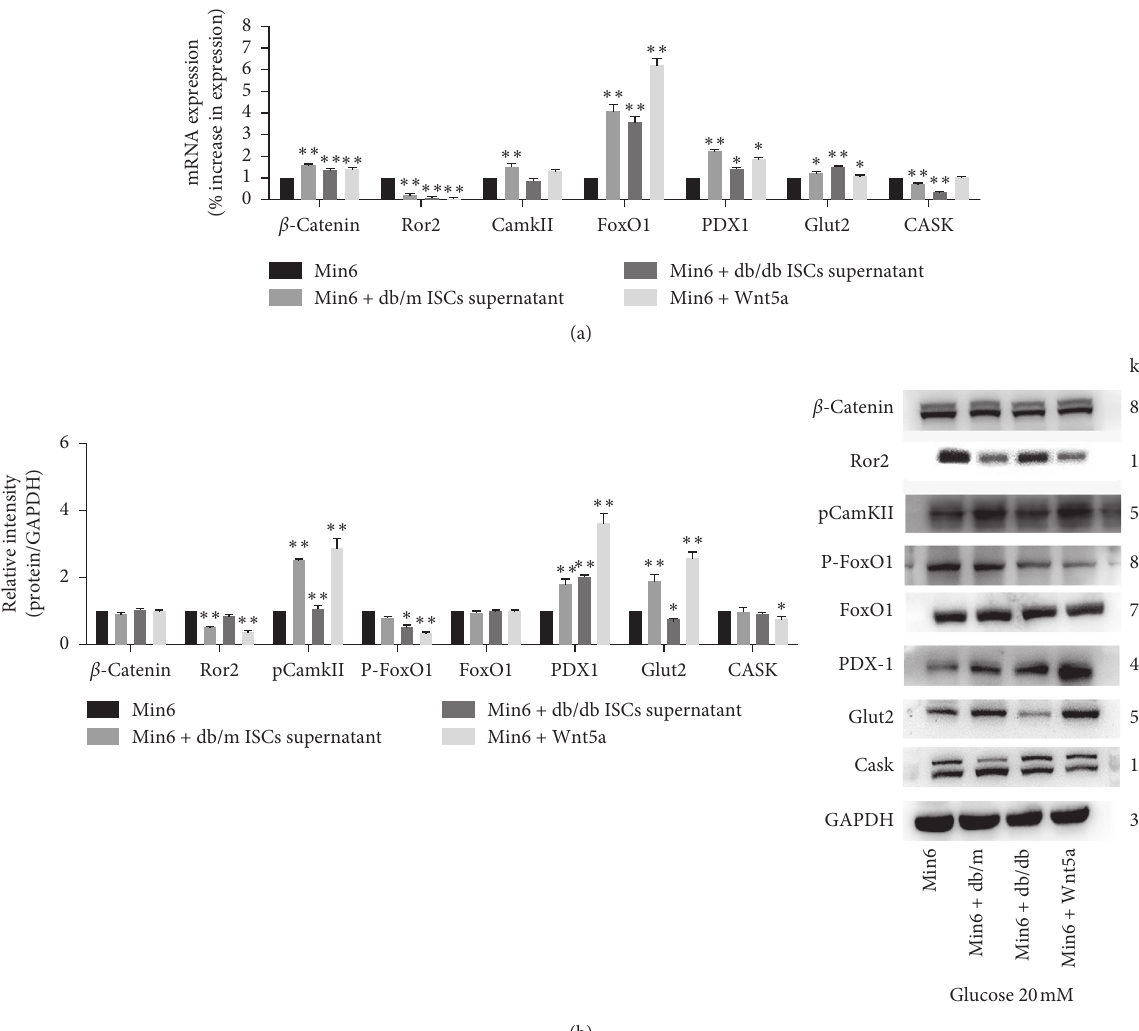
Figure 7: Intracellular mechanism of action of Wnt5a in the regulation of insulin secretion from Min6 cells. (a) GSIS was induced, and qRT- PCR analyses of Min6 cells cultured alone, Min6 cells cultured with ISC supernatant, and Min6 cells cultured with exogenous Wnt5a were performed to measure β -catenin, Ror2, CamKII, FoxO1, PDX1, Glut2, and Cask mRNA level (2mM glucose conditions). ∗ p < 0 . 05 and ∗∗ p < 0 . 01 vs. Min6 cells cultured alone; (b) GSIS was induced, and β -catenin, Ror2, pCamKII, pFoxO1, FoxO1, PDX1, Glut2, and Cask protein levels were quantified by western blotting of Min6 cells cultured alone, Min6 cells cultured with ISCs supernatant, and Min6 cells cultured with exogenous Wnt5a (20 mM glucose conditions). ∗ p < 0 . 05, ∗∗ p < 0 . 01 vs. Min6 cells cultured